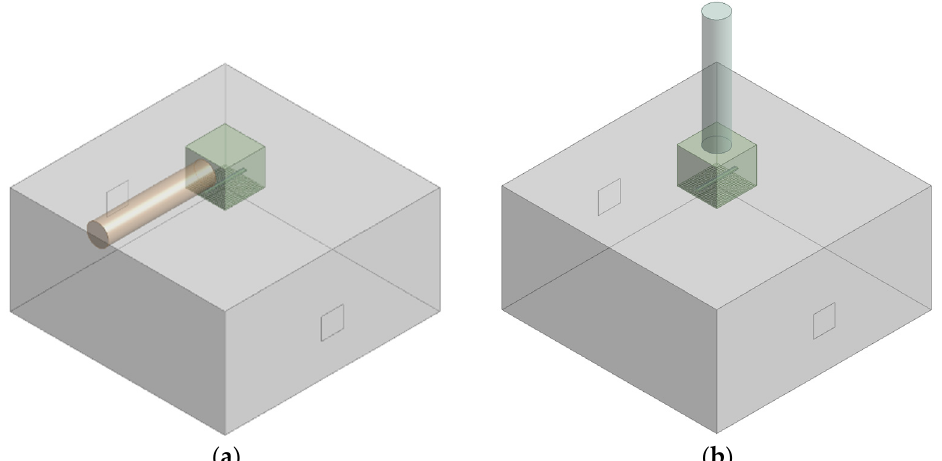
Figure 6. Computational domain for the analysis of plenum box with ( a ) side entry; ( b ) top entry.